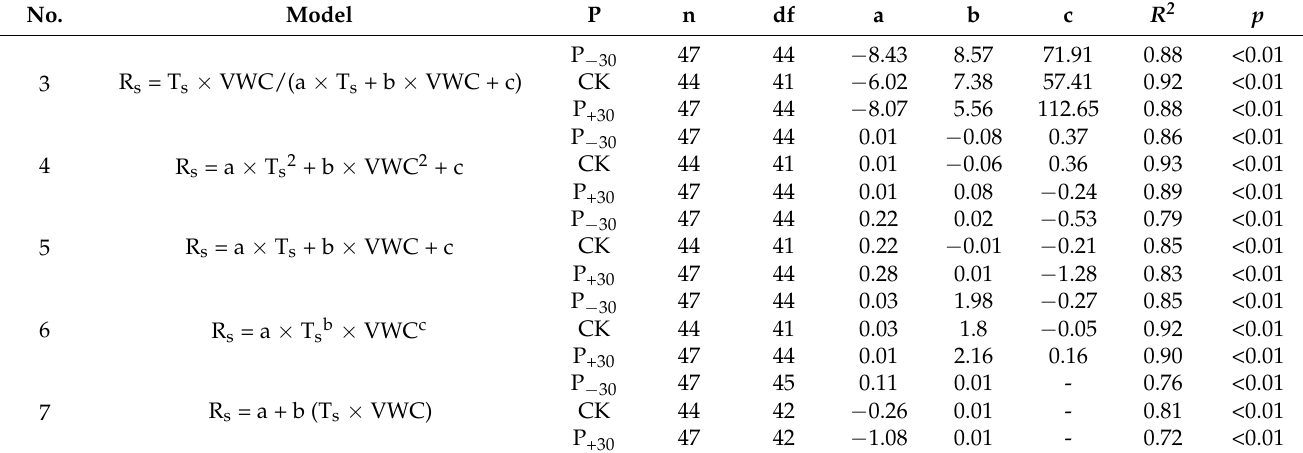
Table 2. Regression equations of soil respiration (R s ) against soil temperature (T s ) and soil volumet- ric water content (VWC).